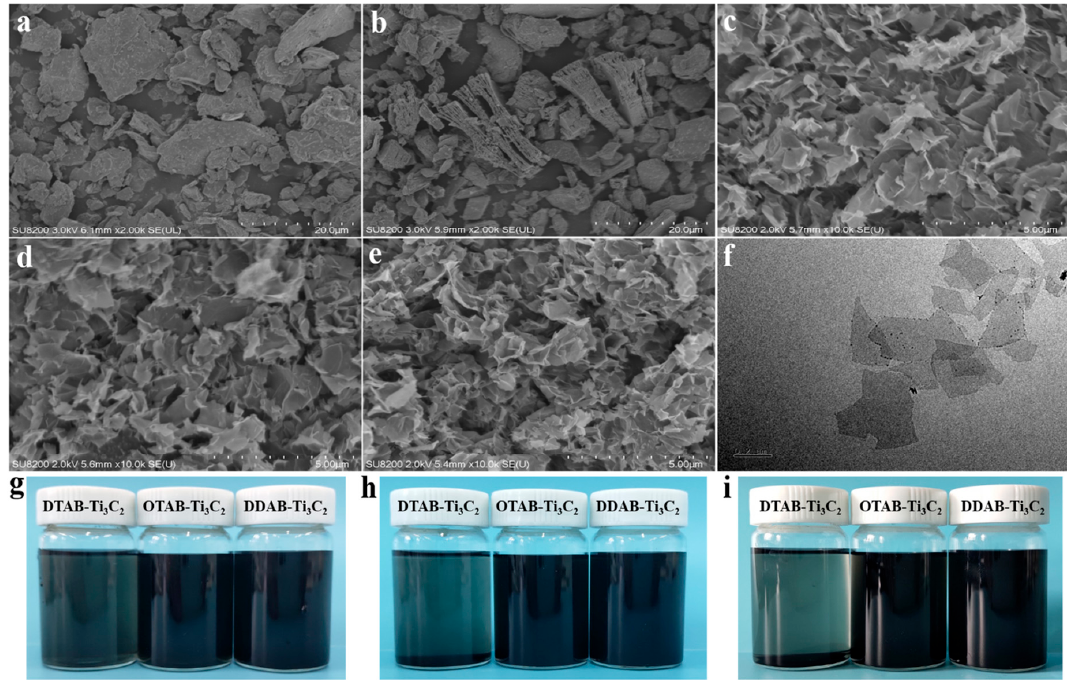
Figure 2. Scanning electron microscopy (SEM) images of ( a ) Ti 3 AlC 2 , ( b – e ) etched Ti 3 AlC 2 , DTAB-Ti 3 C 2 , OTAB-Ti 3 C 2 and DDAB-Ti 3 C 2 ; ( f ) transmission electron microscopy (TEM) image of exfoliated Ti 3 C 2 nanosheets; dispersion of functionalized Ti 3 C 2 nanosheets in N , N -dimethylformamide (DMF) for a period: ( g ) 0 h, ( h ) 6 h and ( i ) 24 h.